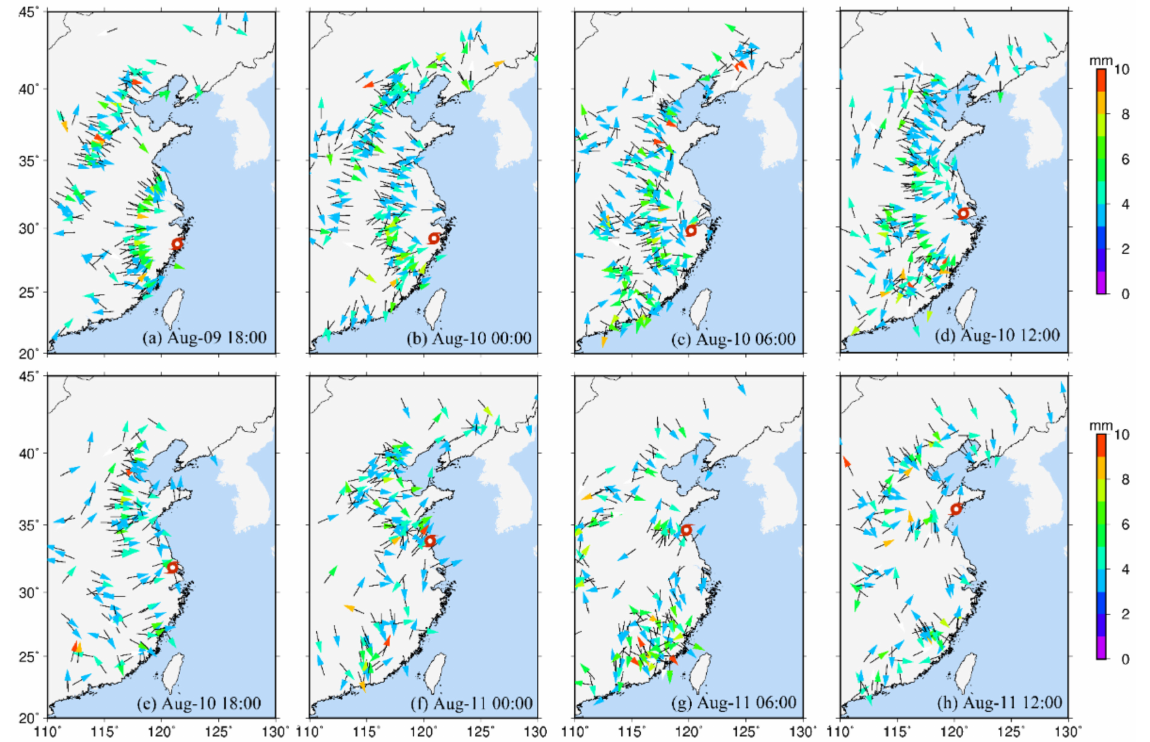
Figure 7. Spatial distribution of HTG (color arrows) at UTC time ( a ) 09 August 18:00, ( b ) 10 August 00:00, ( c ) 10 August 06:00, ( d ) 10 August 12:00, ( e ) 10 August 18:00, ( f ) 11 August 00:00, ( g ) 11 August 06:00, and ( h ) 11 August 12:00. The center of Typhoon Lekima is marked (red symbol) in each